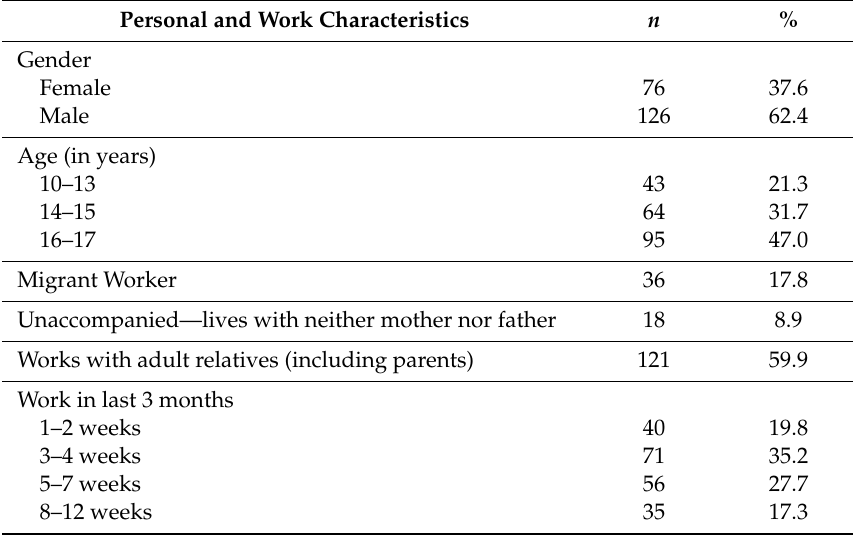
Table 1. Participant personal and work characteristics, Latinx child farmworkers in North Carolina, 2017 (N =